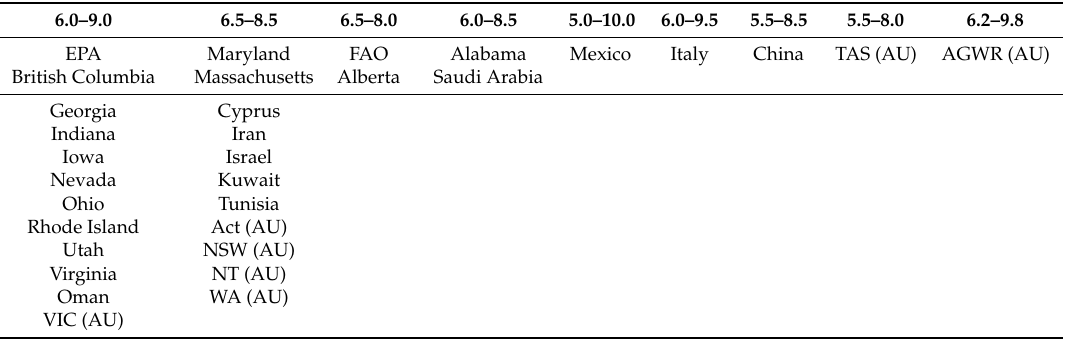
Table 8. pH ranges in the agricultural water reuse regulations and